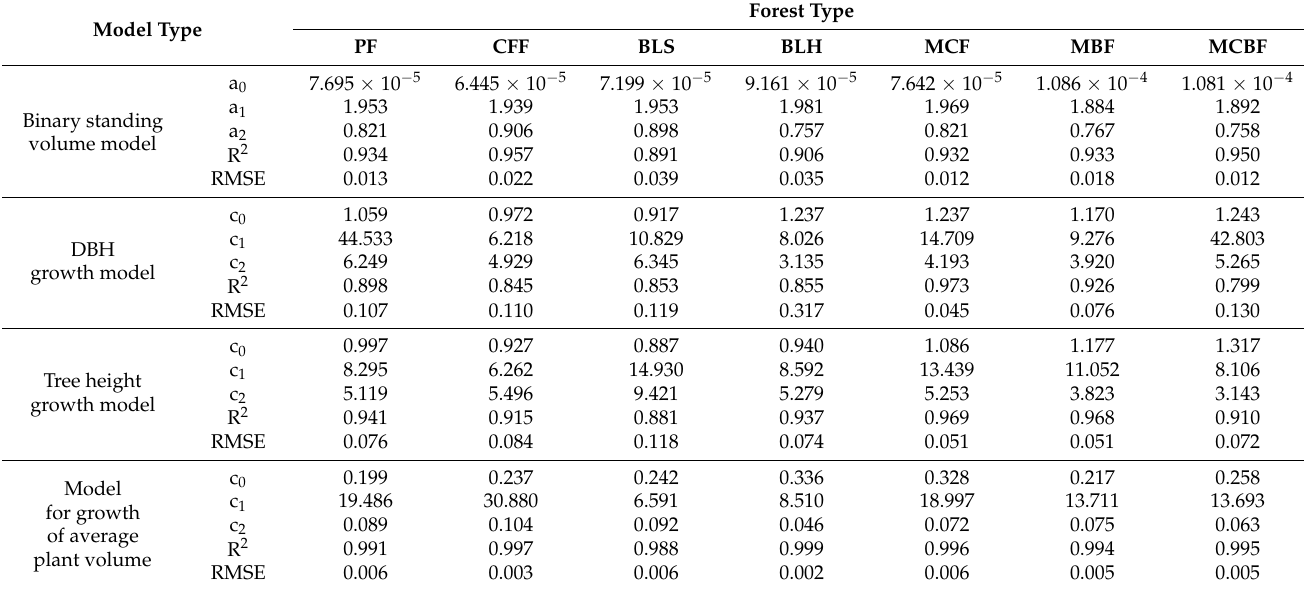
Table 3. Fitting results of the volume growth models in different forest